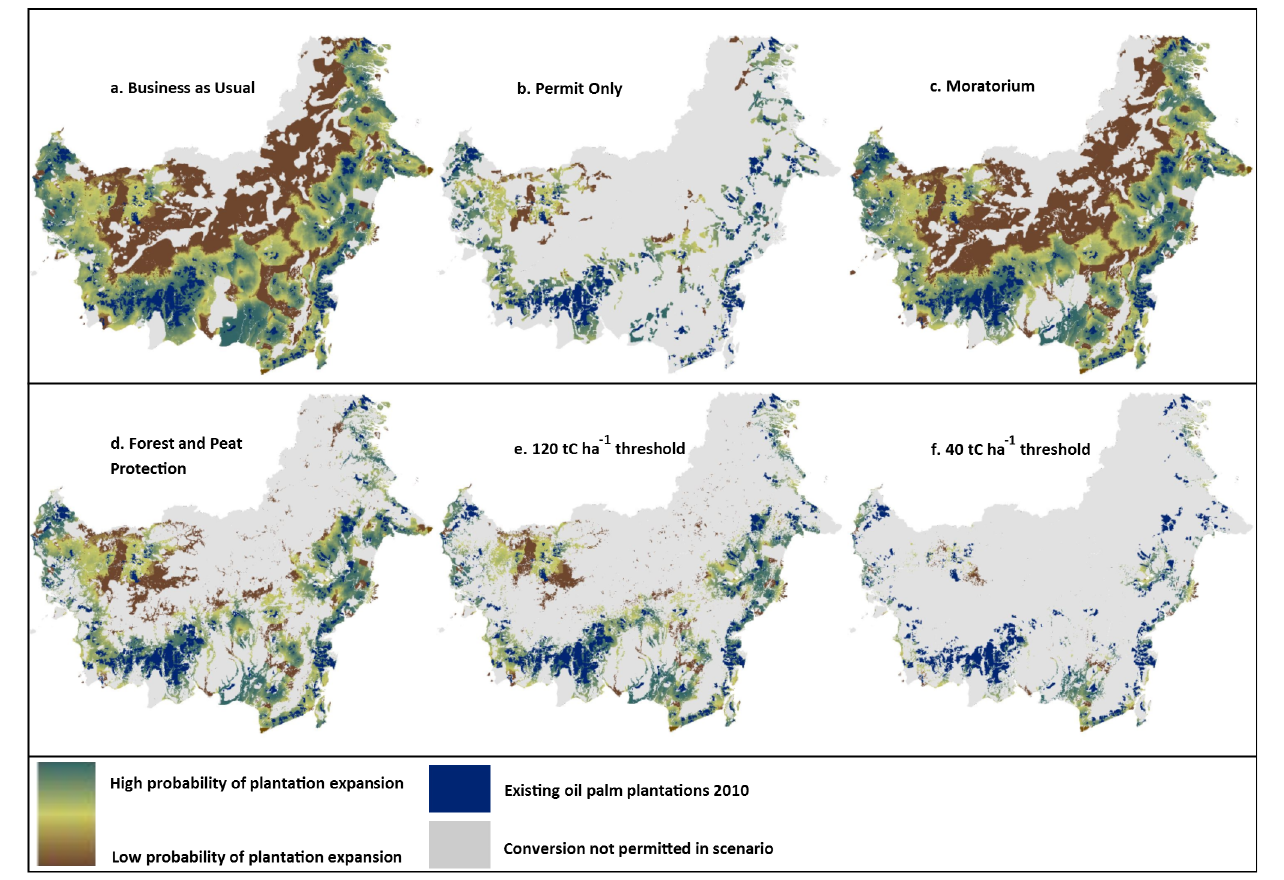
Fig 1. Probability of Oil Palm Plantation Expansion in Kalimantan under six alternative expansion